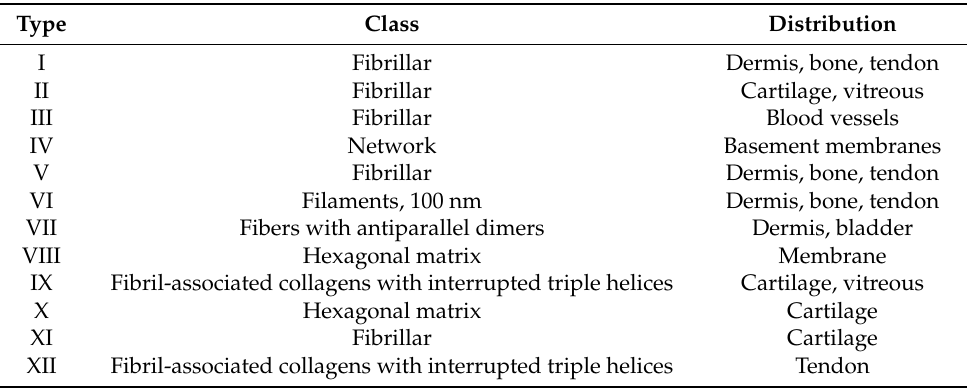
Table 2. The distribution of collagen types in connective tissues